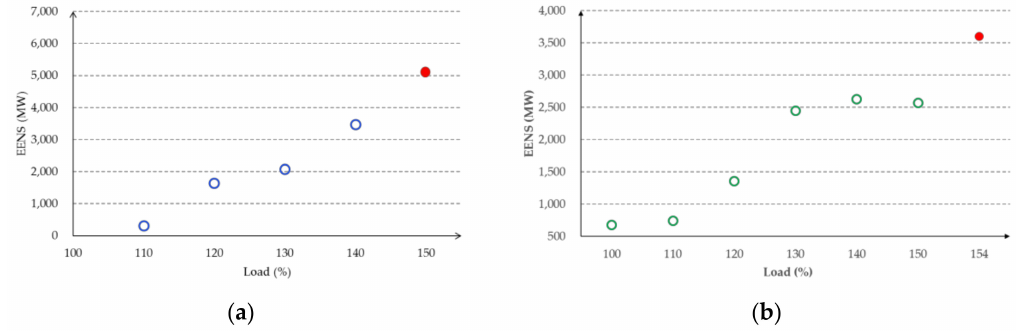
Figure 4. Simulation results of EENS calculation based on load level: ( a ) 2015; ( b )